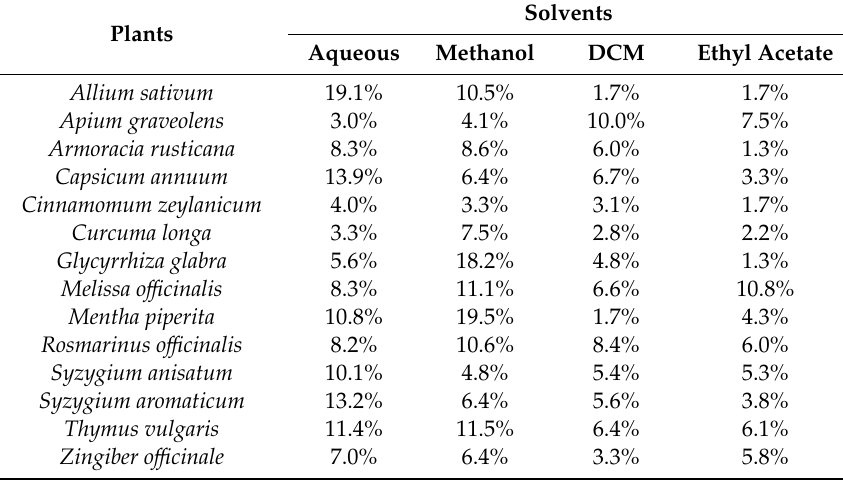
Table 2. Crude extract yields (% w / w ) obtained after extraction of herbs and spices with di ff erent solvents.